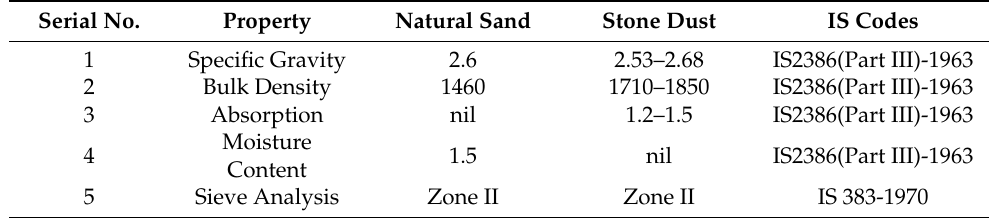
Table 4. Physical characteristics of the stone dust. Serial No.